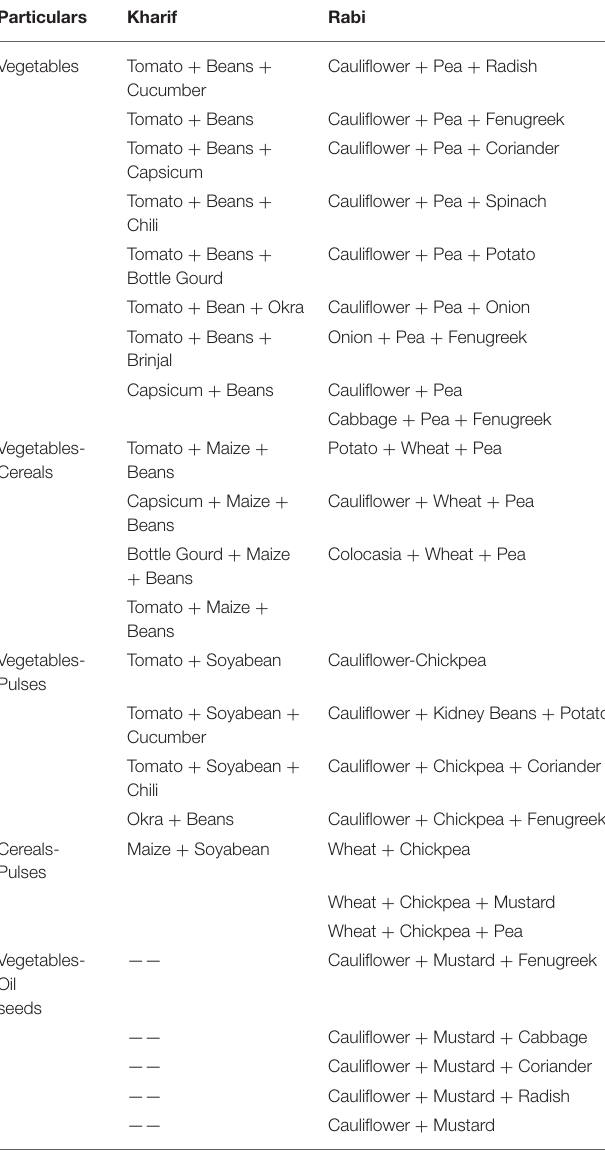
TABLE 7 | Season-wise major crop combinations under natural farming (NF) system. Particulars